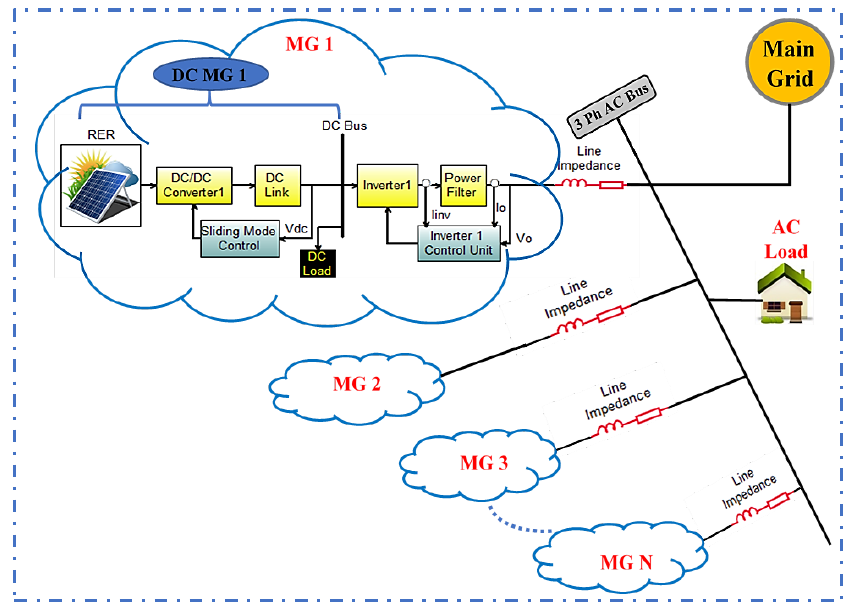
Figure 1. Parallel decentralized MGs.